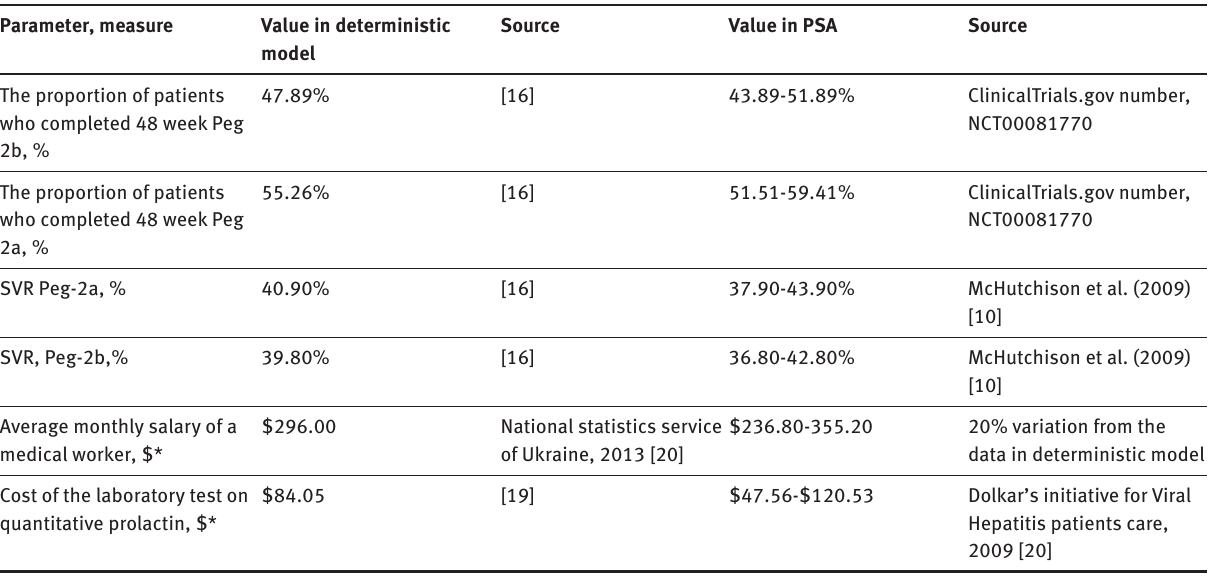
Table 2: Decision-tree model input parameters Parameter, measure